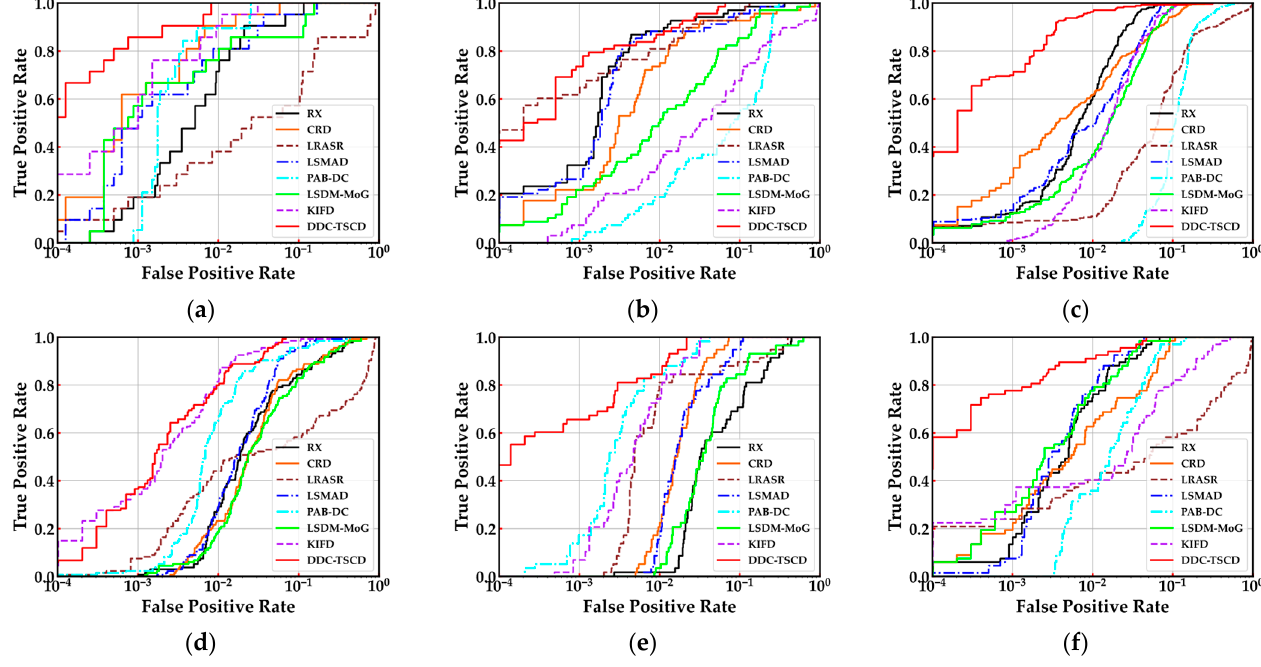
Figure 13. ROC curves for different methods on ( a ) HYDICE, ( b ) Pavia, ( c ) Los Angeles, ( d ) San Diego-I, ( e ) San Diego-II and ( f ) Texas Coast.